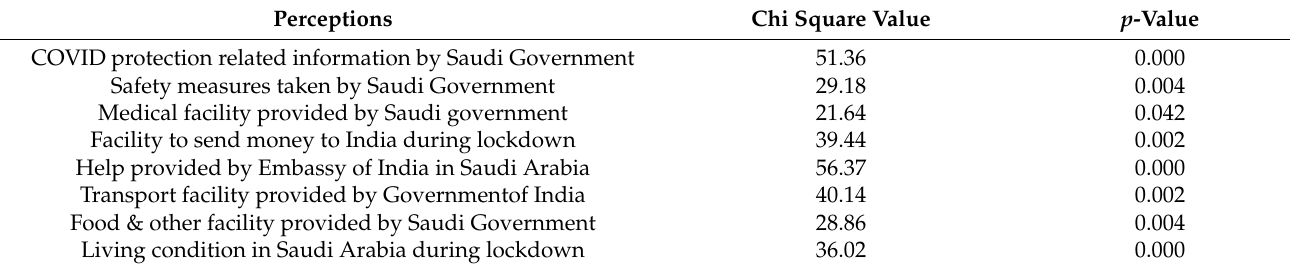
Table 8. Chi-Square Analysis of Perceptions of COVID-19 Management by Govt. Within Different Professions/Occupations.